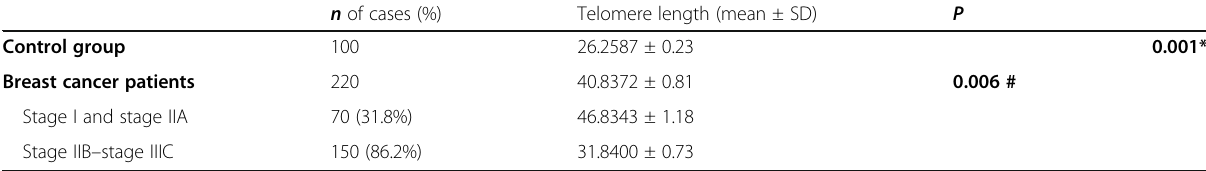
Table 2 Association between telomere length in breast cancer patients in various stages and control groups Telomere